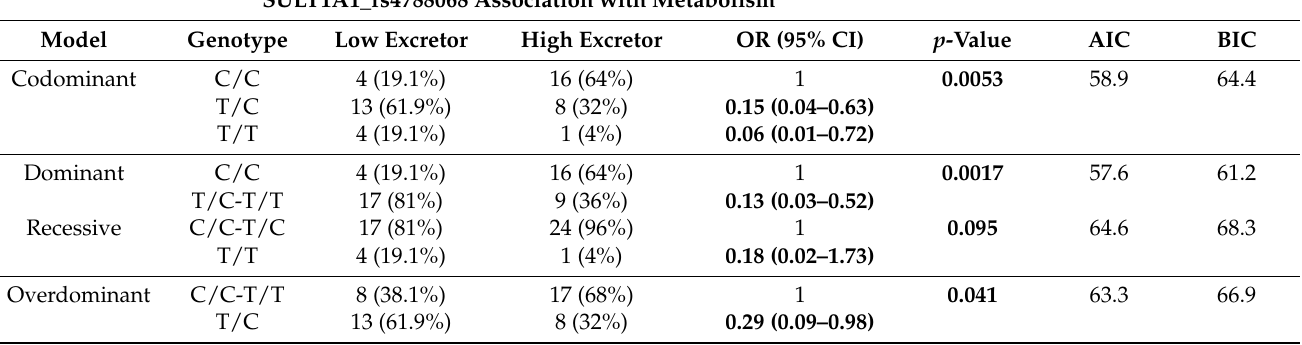
Table 8. Analysis of association of SULT1A1_rs4788068 polymorphism with the excretion of phase II flavanone metabolites in urine of studied volunteers after single dose of orange